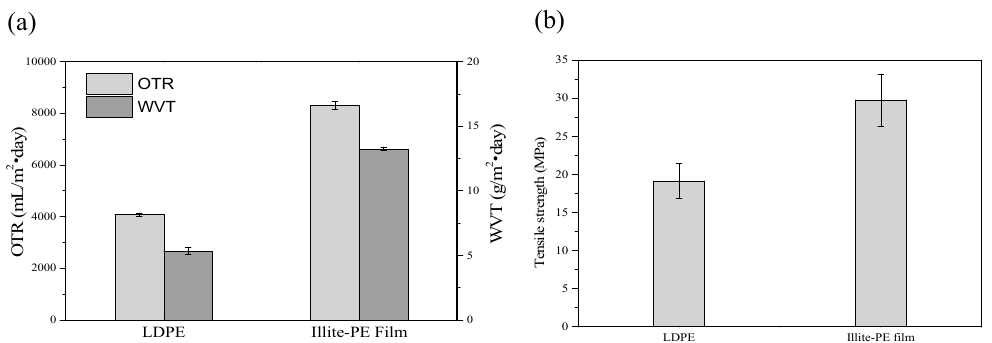
Figure 4. Comparison of ( a ) oxygen transmission rate (OTR) and water vapor transmission rate. (WVTR), and ( b ) tensile strength of control LDPE and illite-PE film.